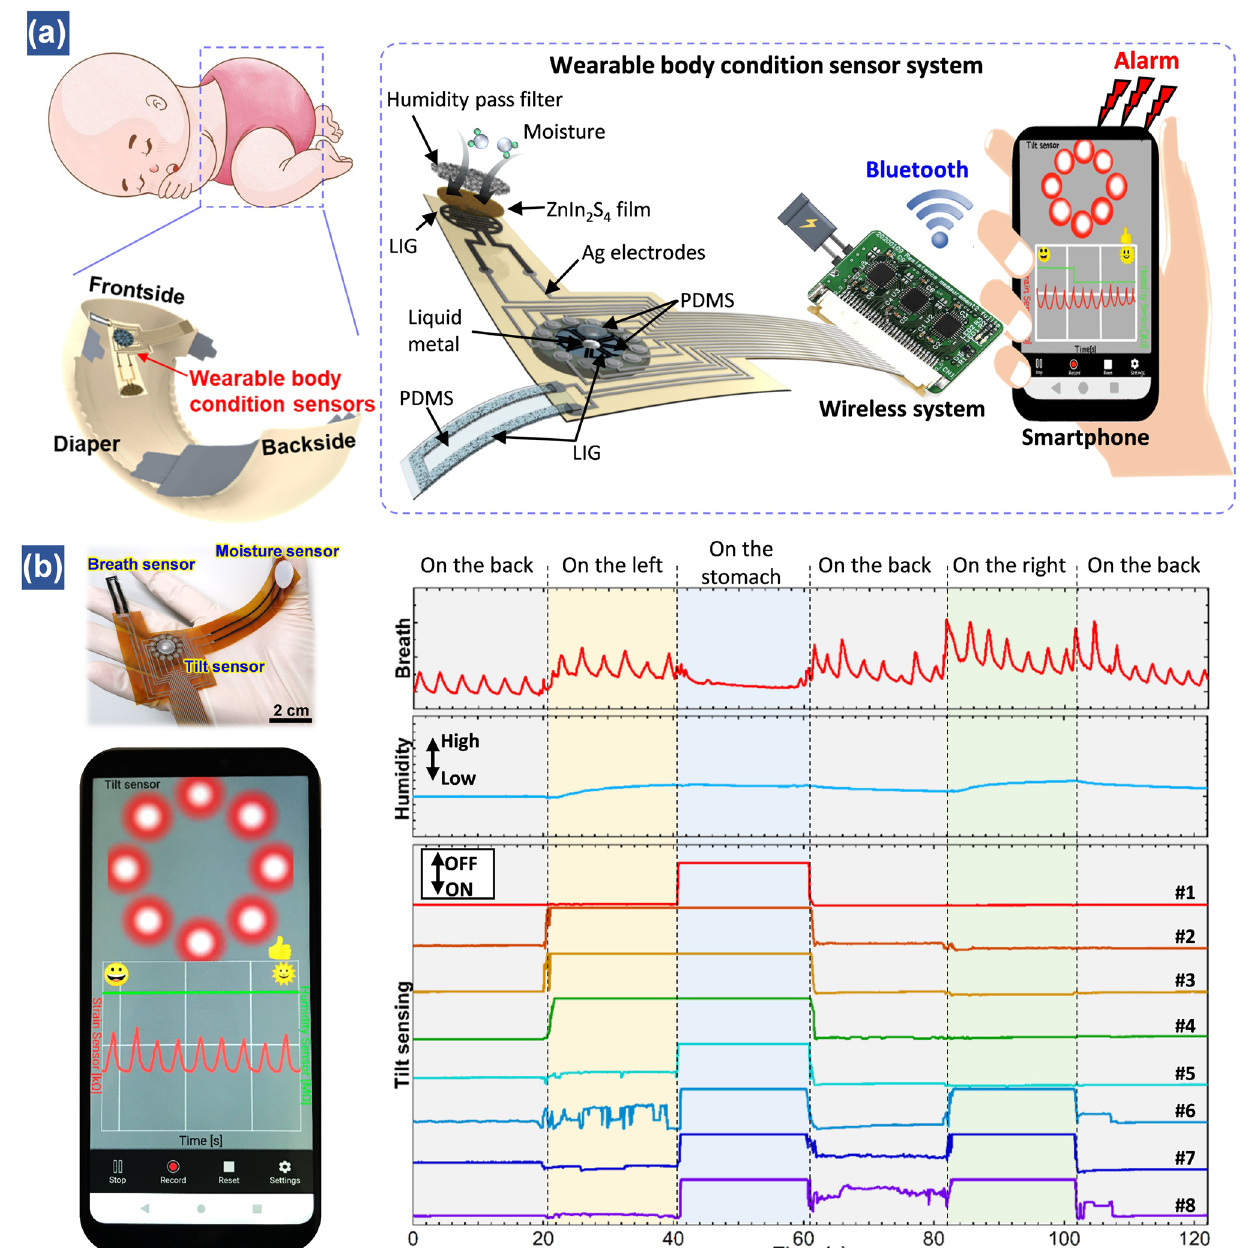
Fig. 12 Multimodal humidity sensor-based systems with feedback functions. ( a ) Schematic of the wearable sensor system attached onto a dis- posable diaper, the sensor system is integrated with tilt, breath, and moisture sensors. Multiple channel signals are wirelessly transmitted to a smartphone interface via Bluetooth. The smartphone can generate an alarm under certain conditions. ( b ) Wireless real-time monitoring results measured from an adult lying on a mattress [58]. Copyright 2021